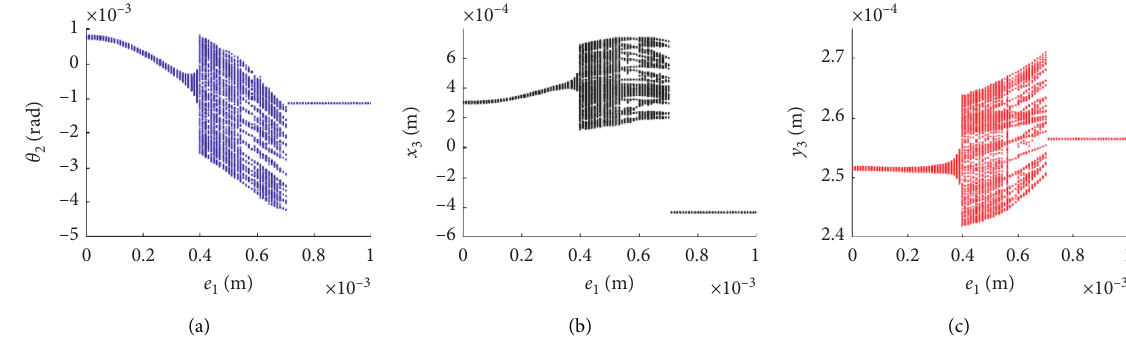
–0.3–0.2–0.100.10.20.3 ×10 –4 Figure 7: Bifurcation diagram under 0.3 mm structure gap: (a) torsional direction; (b) vertical direction; (c) horizontal